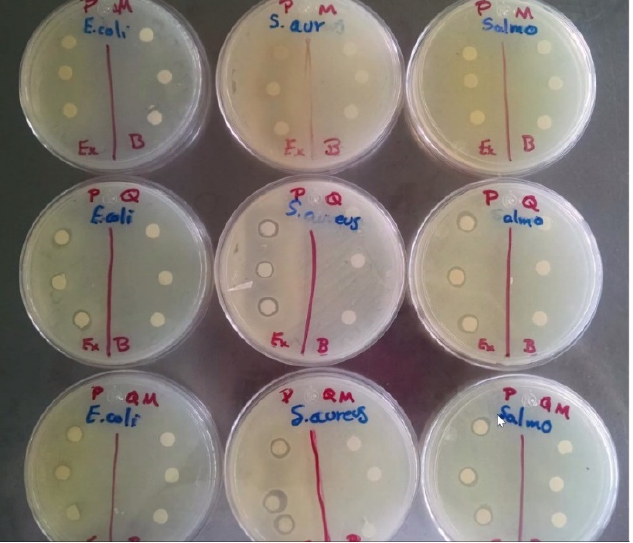
Figure 2. Halos of Inhibitory zone of P = EC; Q = ECCh; M = ECP; QM =